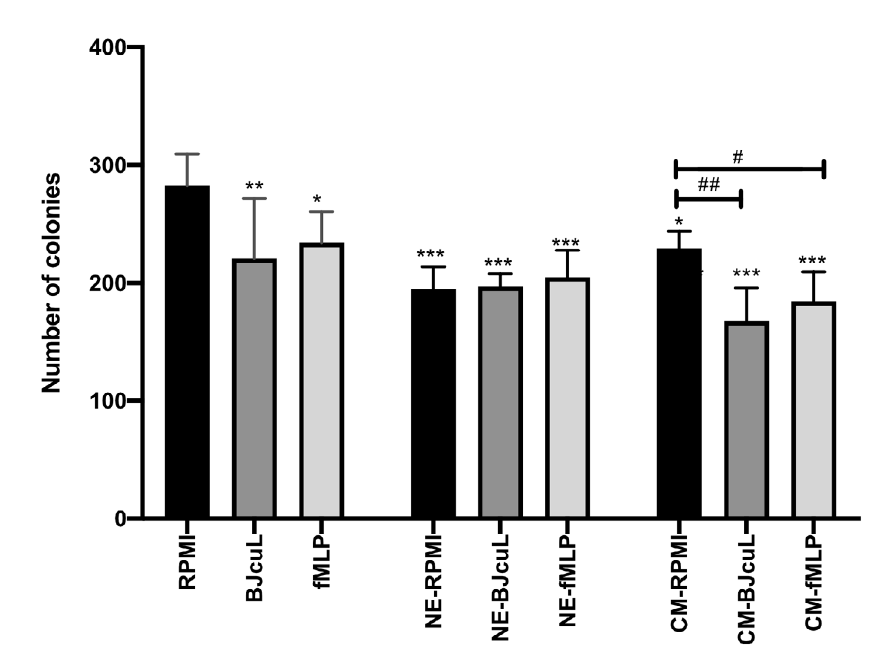
Figure 4. Anchorage-free survival assay of SK-N-SH cells after incubation with various stimuli. SK-N-SH cells (2 x 10 3 cells/well) were incubated for 24 h with RPMI, BJcuL (2.5 μg/mL) or fMLP (10 μM), or conditioned neutrophil media (CM-RPMI, CM-BJcuL or CM-fMLP). SK-N-SH cells were also stimulated for 24 h with neutrophils in association with BJcuL, fMLP or 2% RPMI. After treatment SK-N-SH cells were dissociated, washed and plated on a mirror plate containing soft agar layers. Results are represented as mean ± SD (n = 8) of the total number of colonies counted in each well. Data were collected from at least two independent assays. The statistical comparison among groups was performed by one-way ANOVA (p < 0.05). Dunnetts’s test was used to compare all treatments with the RPMI group. Significance is represented as *p < 0.05; **p < 0.005 and ***p < 0.001. # represents the comparison of treatments with the respective control